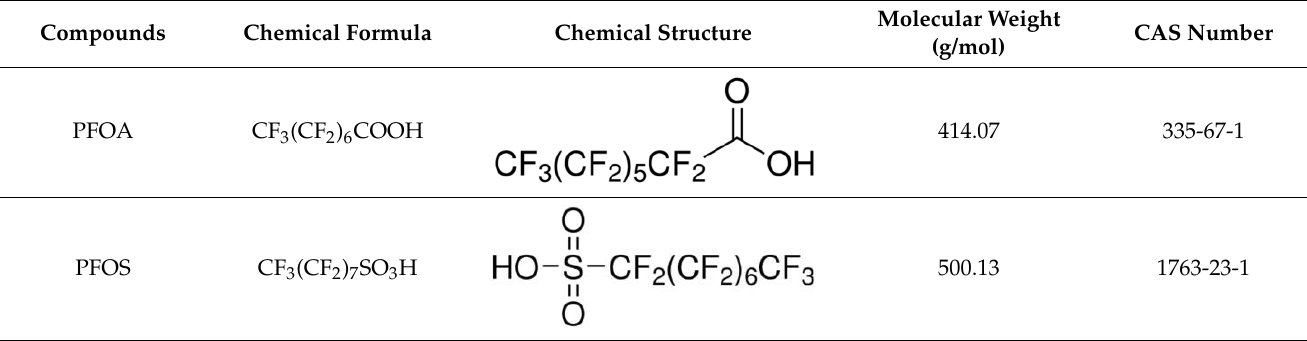
Table 4. Characteristics of PFOA and PFOS.